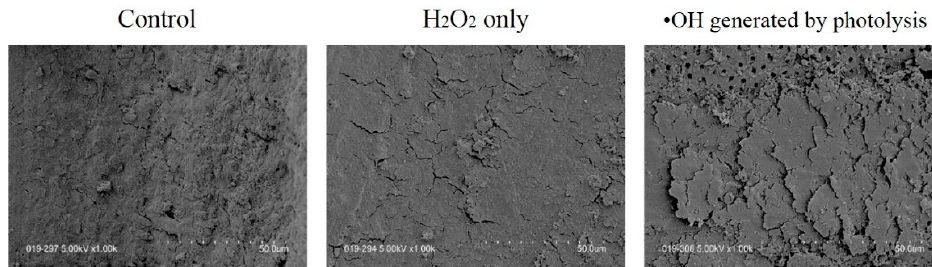
Figure 9. Comparison of typical scanning electron microscopy images of root canal surfaces. The control sample is entirely covered by a smear layer, and H 2 O 2 alone causes a smear layer similar to fish scales but no dentin tubules are observed. In photolysis, more smear layers resembling fish scales are observed, and dentin tubules are clearly visible. Reprinted/adapted with permission from Ref [58], 2021, the Quintessence.